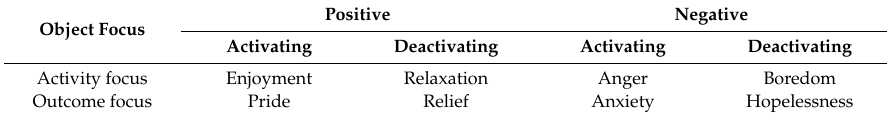
Table 1. Example of achievement emotions classified by valence, activation and object